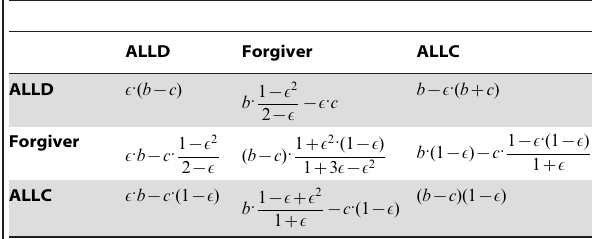
Table 3. Analytical results in the infinitely alternating Prisoner’s